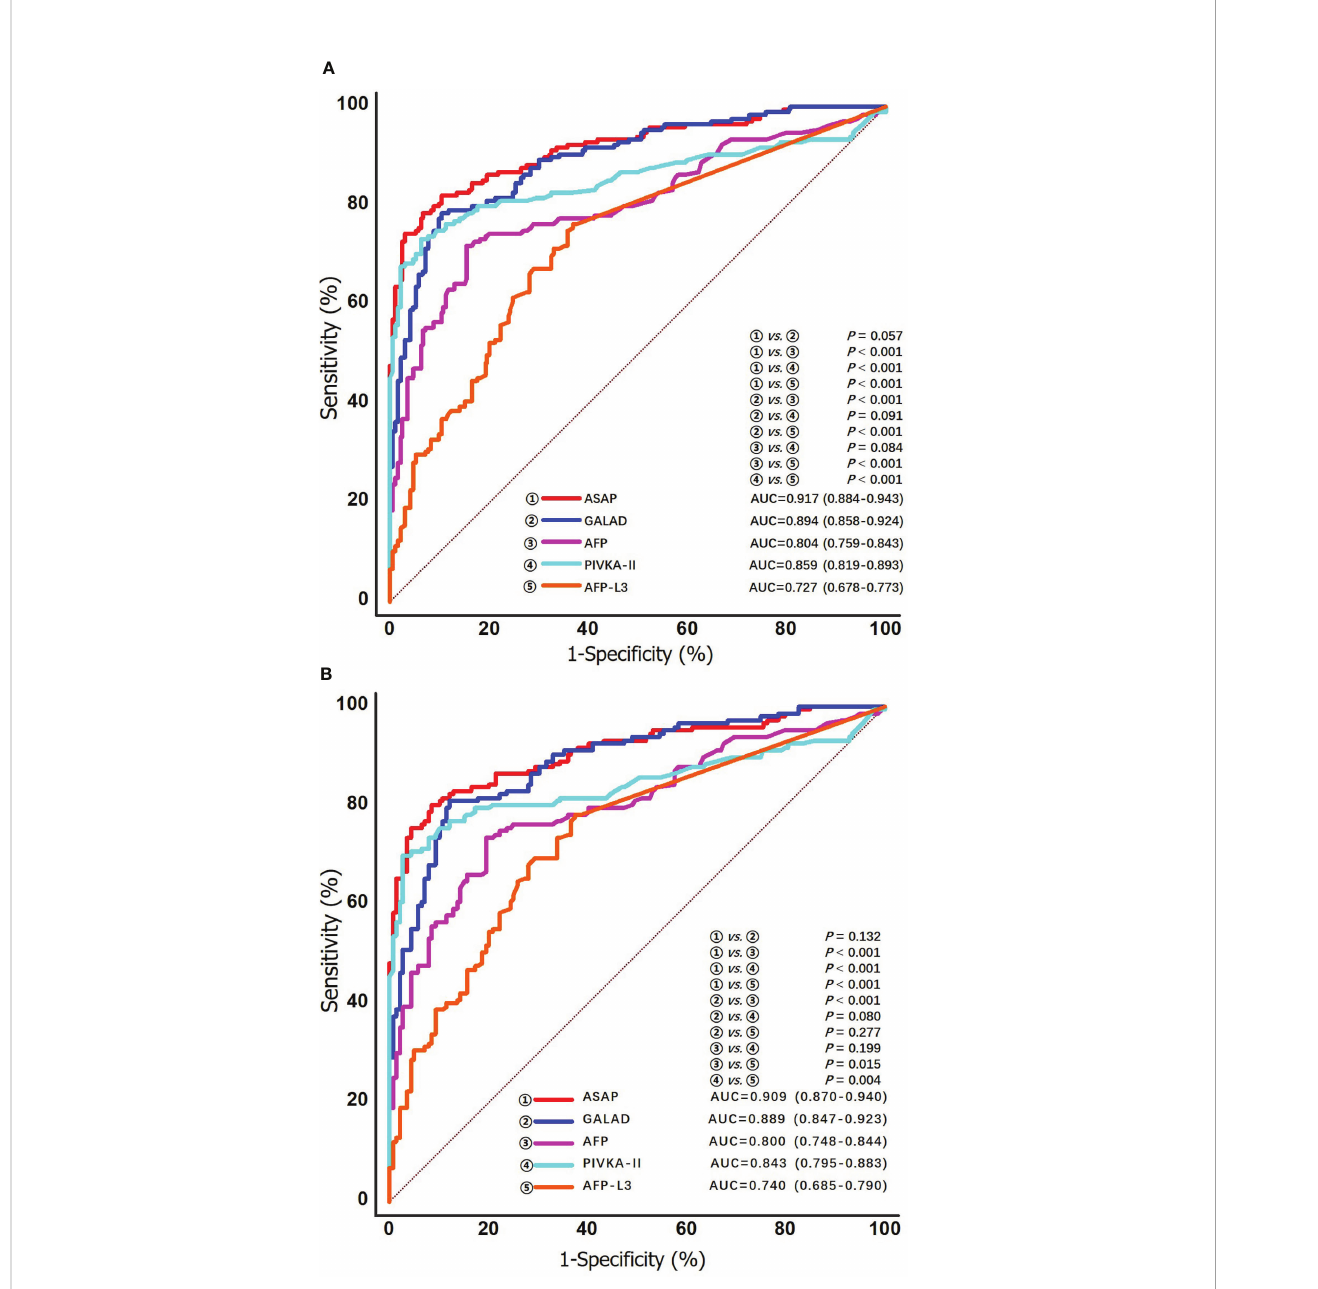
FIGURE 3 ROC curves of the ASAP score, the GALAD score, AFP, PIVKA-II and AFP-L3% for detecting any stage HCV-HCC in the overall group (A) and the cirrhosis subgroup (B)